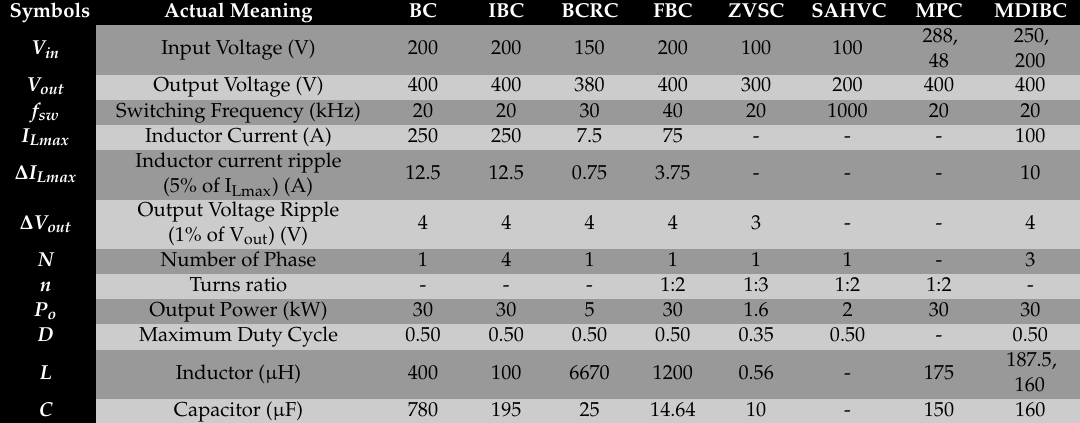
Table 3. Specification values for passive components of DC-DC